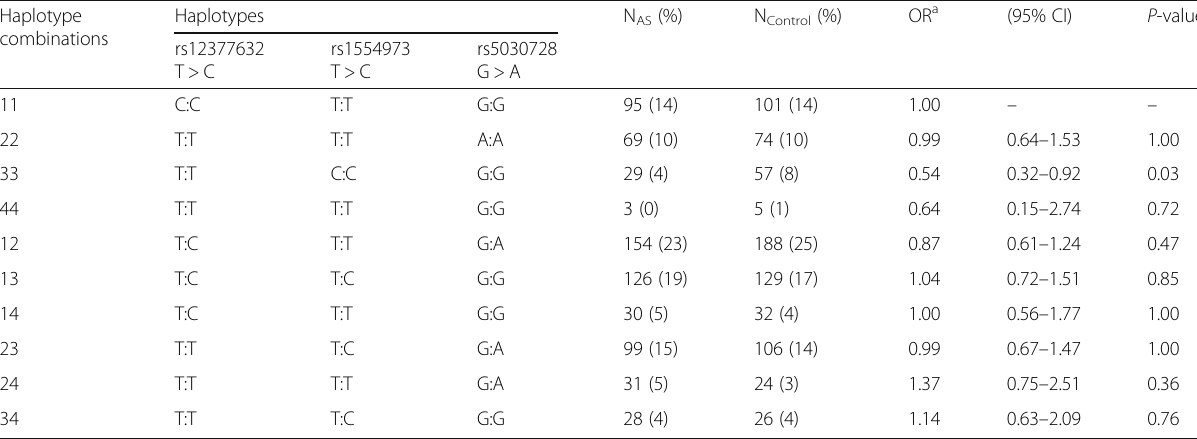
Table 4 Association between TLR4 haplotype combinations and risk of ankylosing spondylitis (AS). The haplotype combinations in TLR4 described 94% of the genotypes observed Haplotype